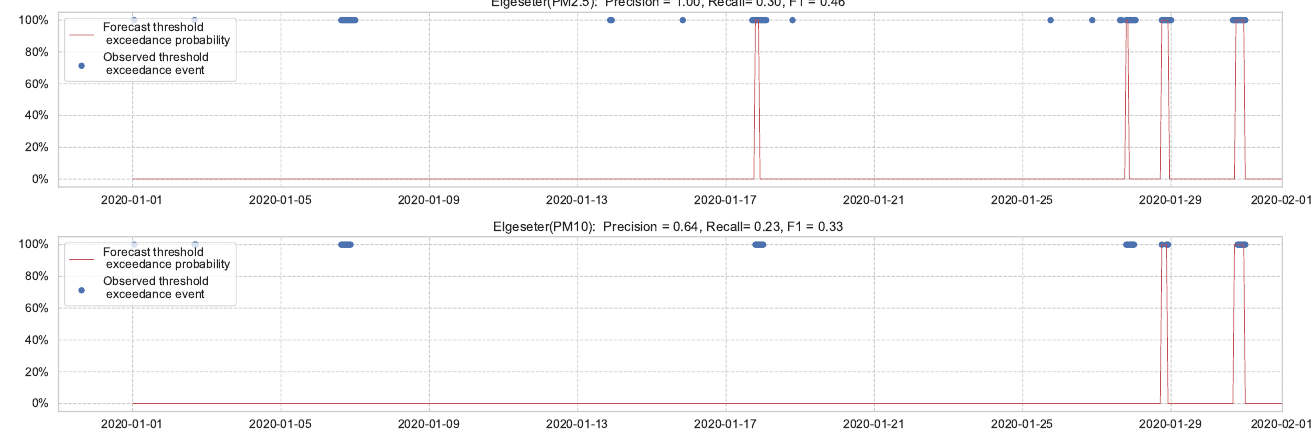
Figure 12. Predicting threshold exceedance probability by transforming PM-value regression into binary predictions.